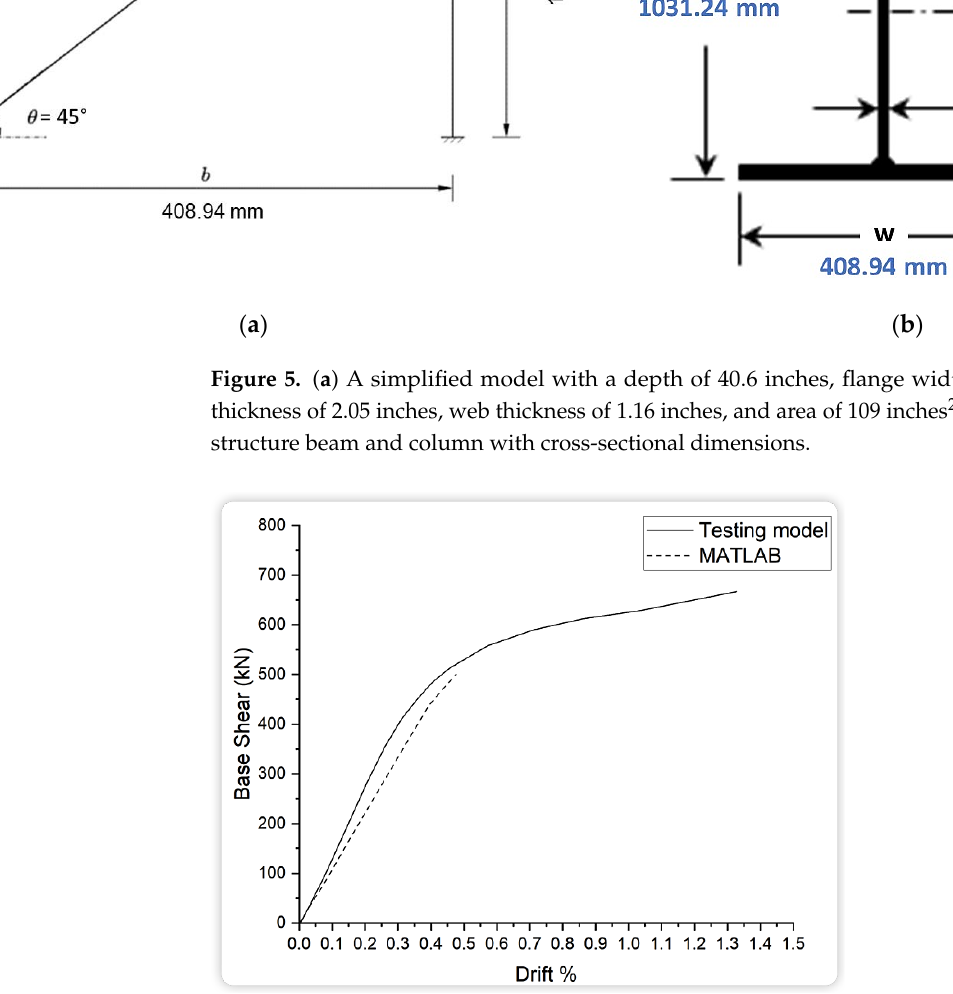
Figure 6. Comparison of numerical (MATLAB) and testing model results.